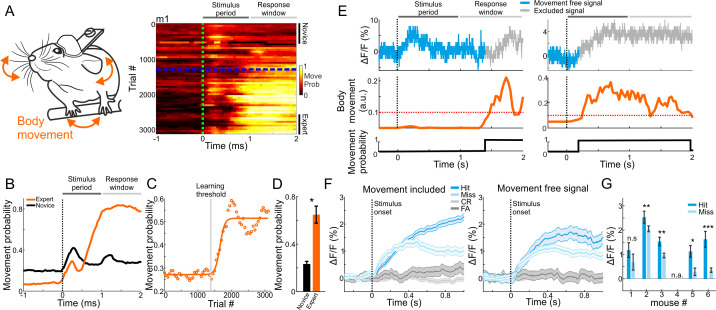
Body movements affect MGB responses.(A) Left: schematic illustration of mouse body movements during the task. Right: A 2-dimensional plot of movement probability during go trials within the trial (x-axis) and across learning (y-axis; 50 trial bins) for an example mouse. Dashed green line indicates stimulus onset (1 s duration) and dashed blue line indicates learning threshold. Color scale bar indicates min/max of movement probability. (B) Movement probability during the trial for the example mouse in A when it was novice (black) and expert (orange). (C) Movement probability (averaged during late times; 0.6–1 s after stimulus onset; go trials) across learning fitted with a sigmoid function. Same data as in ‘B’. (D) Movement probability during late times for novice and expert averaged across all six mice. Error bars are s.e.m across mice. *p<0.05. Signed-rank test. (E) Single trial traces of MGB calcium response (top), body movement (middle) and a binary movement vector (bottom; thresholding the body movement, dashed red line; Materials and methods). To exclude effects of body movements, MGB responses were truncated just before the movement onset on a trial-by-trial basis (gray traces in each trial). (F) MGB calcium responses for different trial types when including (left) and excluding (right) body movements. Data is from one example mouse (same as Figure 2B). Error bars are s.e.m across trials. (G) Mean MGB responses (averaged during stimulus presentation) for movement-free hit and miss trials per mouse. Data from expert mice. Error bars are s.e.m across trials. *p<0.05. **p<0.01. ***p<0.001. n.s. – not significant. n.a. – not available. Wilcoxon rank sum test.